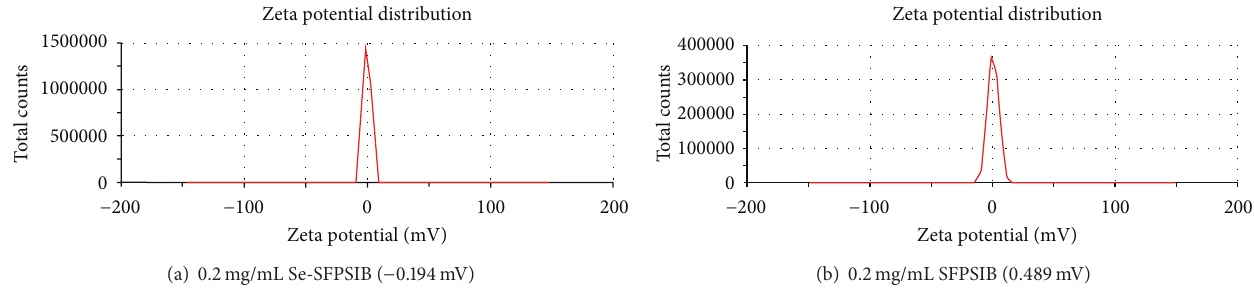
Figure 4: Zeta potential distribution curves recorded for Se-SFPSIB and SFPSIB.